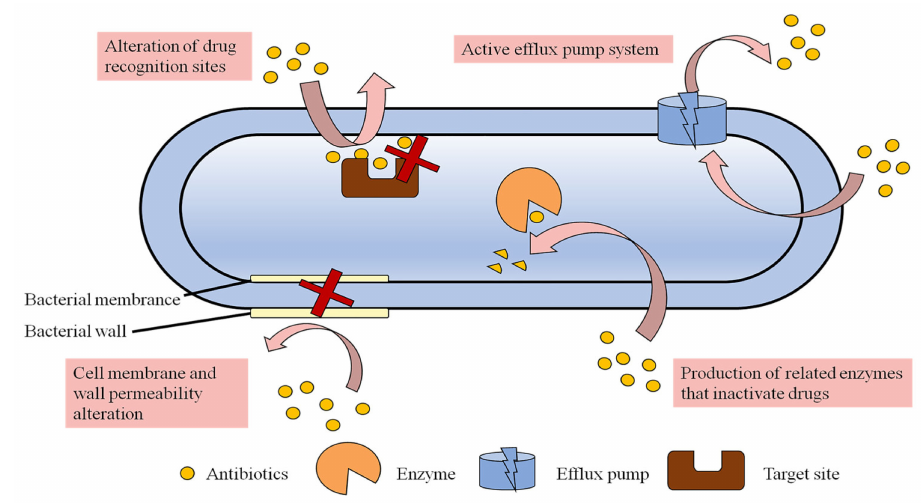
Figure 3. Mechanisms of antibiotic